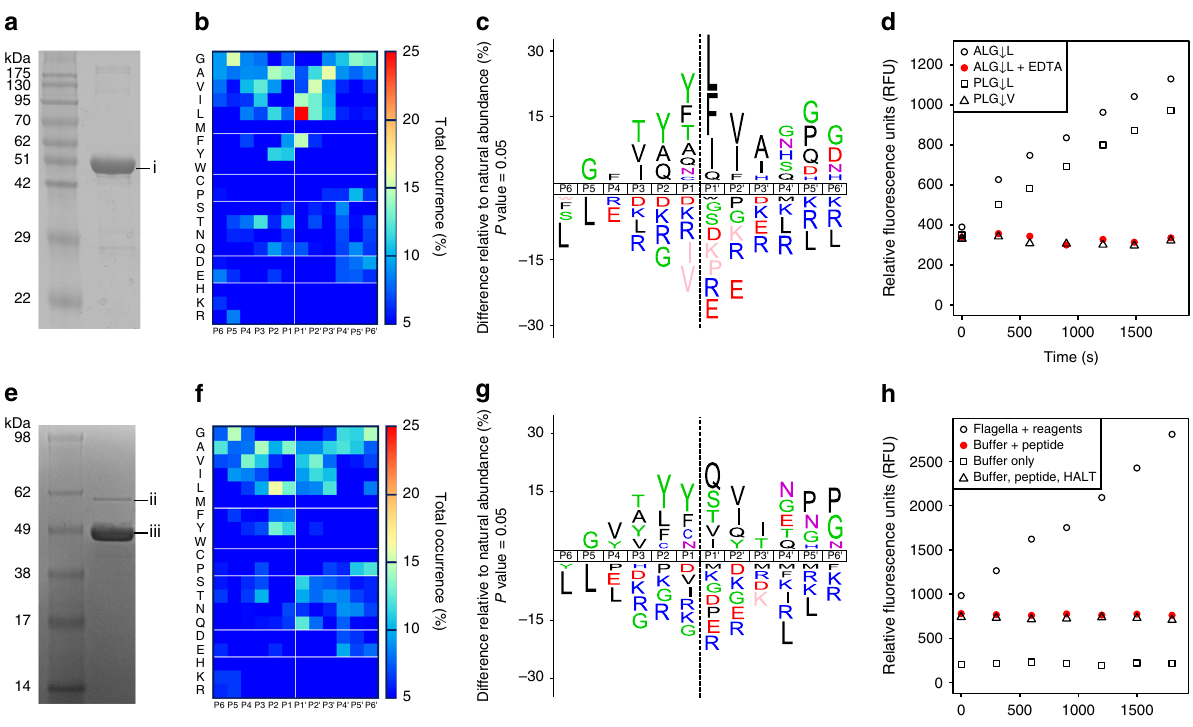
Fig. 4 Peptidase activity assays of puri fi ed recombinant FliA(H)-hypervariable region and fl agellar fi laments from C. haemolyticum . a 12% SDS-PAGE of puri fi ed FliA(H)-hypervariable region (band “ i ” ), electrophoresing close to that predicted for recombinant thioredoxin-tagged fl agellin hypervariable region (50.14 kDa). b Amino acid occurrence heat map based on FliA(H)-hypervariable region protease cleaved peptide alignments of 391 cleavage sites identi fi ed in a tryptic E. coli K12 library. c IceLogos of FliA(H)-hypervariable region protease cleaved peptide speci fi city pro fi les showing percent differences compared to natural amino acid abundance, with signi fi cantly over-represented amino acids shown above the x -axis and under-represented residues below the x -axis. Amino acids that have not been identi fi ed are depicted in pink . d Fluorometric peptidase assays for FliA(H)-hypervariable region protease against three different peptidic substrates (ALG ↓ L, PLG ↓ L, PLG ↓ V) and + / – EDTA as indicated. e 10% SDS-PAGE of puri fi ed fl agellar sheared fi laments from C. haemolyticum . Band “ ii ” and “ iii ” were identi fi ed by mass spectrometry as FliA(H) (proteolytic fl agellin) and the non-protease-containing structural fl agellin (WP_039229459), respectively (Supplementary Fig. 7). f Amino acid occurrence heat map and g IceLogo based on cleaved peptide alignments